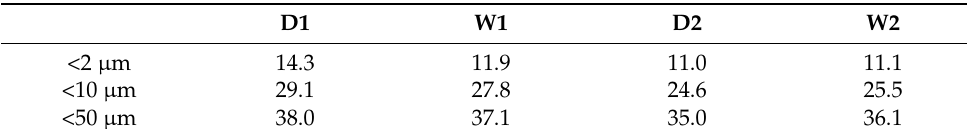
Table A8. Aggregate representation percentage in the sediment depending on initial condition, slope 34° [%].